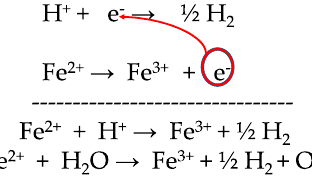
Figure 1. Process of oxidation of the redox couple Fe 3+ /Fe 2+ by the redox couple (H + /H 2 ).